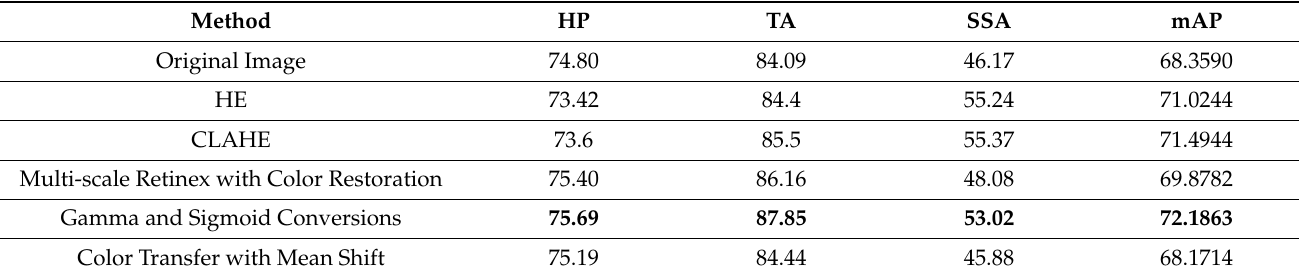
Table 3. mAP results of 3 color transfer methods in 3 polyp classes.